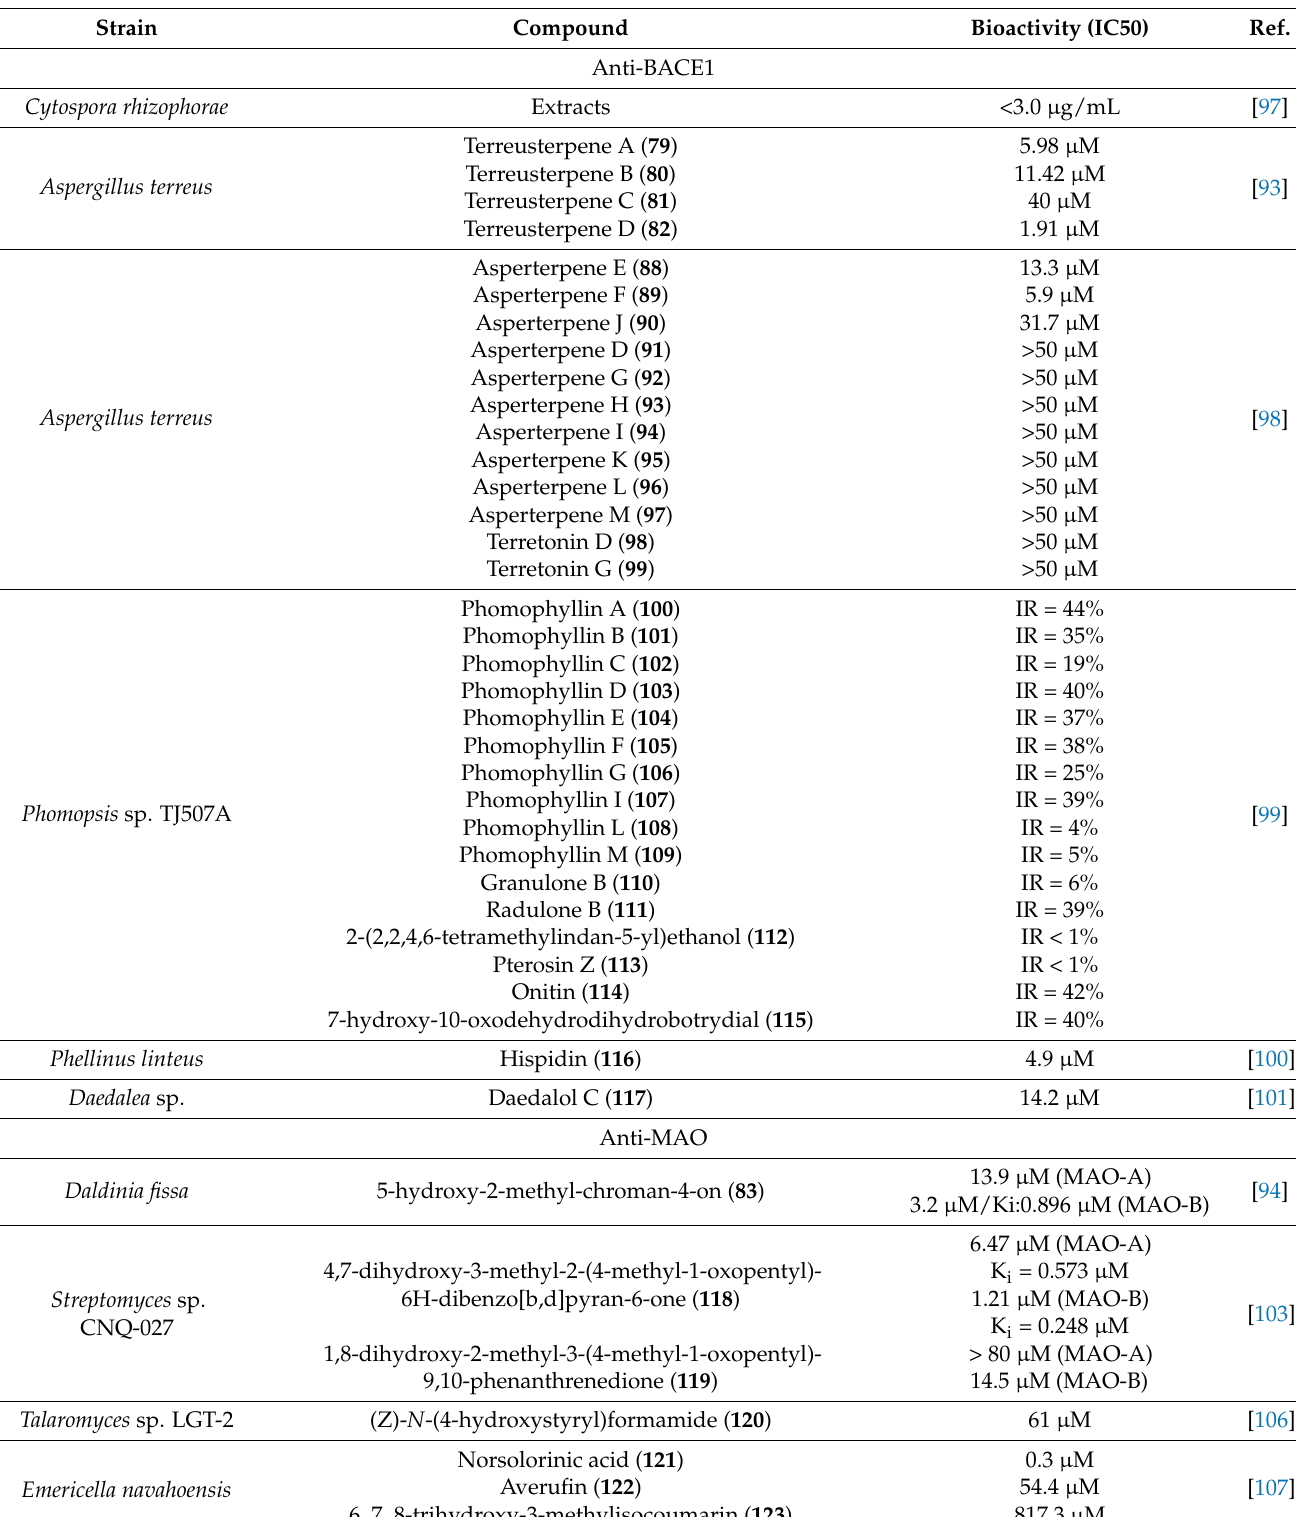
Table 3. Inhibitors of other target enzymes in Alzheimer’s disease from